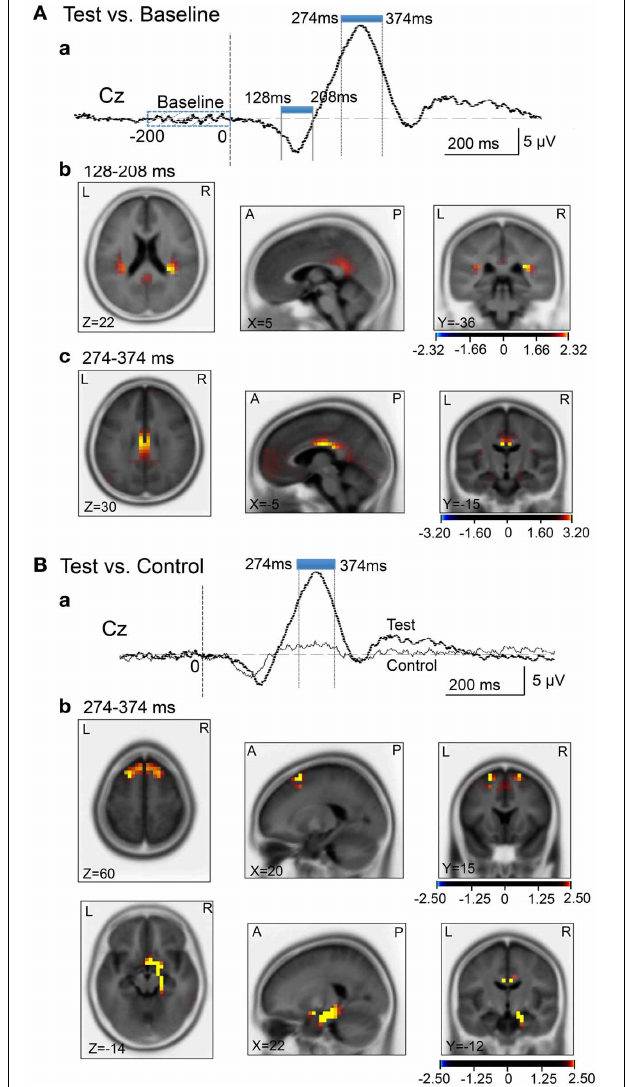
FIGURE 8 | sLORETA statistical nonparametric maps comparing the current source density in the baseline before arrival at the spatial reference points and ERPs after arrival (A), and comparing the current source density in the ERPs between the control and test phases (B). (A) Significant increase in current source density in the ERPs compared with the baseline at the 128- to 208-ms (b) and the 274- to 374-ms (c) latencies; (a) analyzed time windows indicated by blue thick lines. (B) Significant increase in current source density of the ERPs in the test phase compared with the control phase at the 274- to 374-ms (b) latency; (a) analyzed time windows indicated by blue thick lines. Calibration bars indicate t -values.